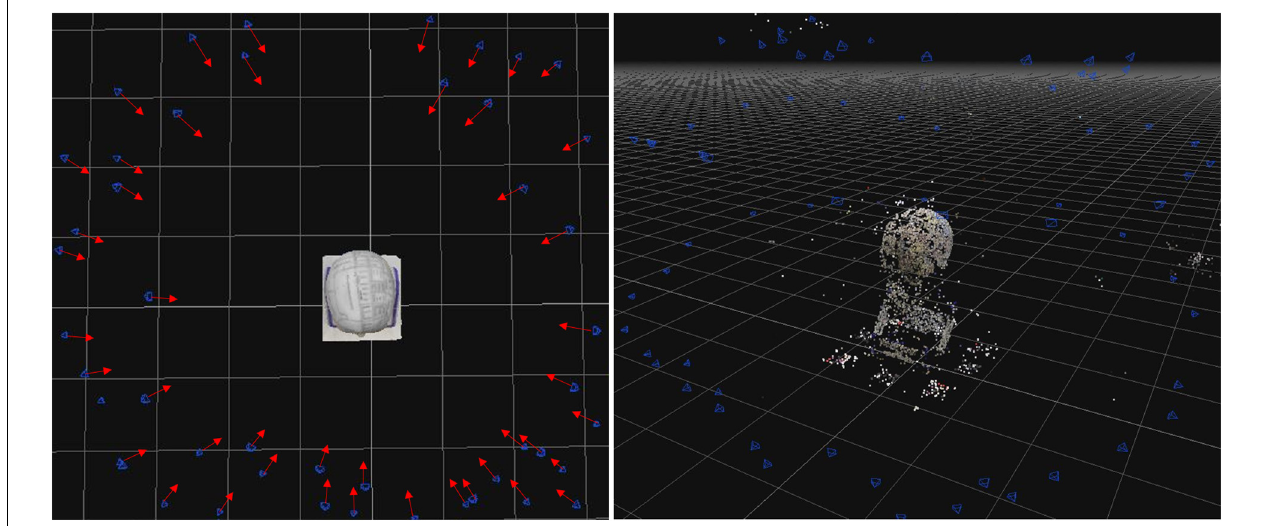
FIGURE 1 | A screenshot showing how a PR3DM is created using a series of photographs. The blue cones represent the camera positions of photographs of a physical object (left) , preliminary coordinates are calculated (right) , screenshots are taken in 3DF Zephyr Lite (3Dflow, 2019), and arrows are added to indicate camera orientations.